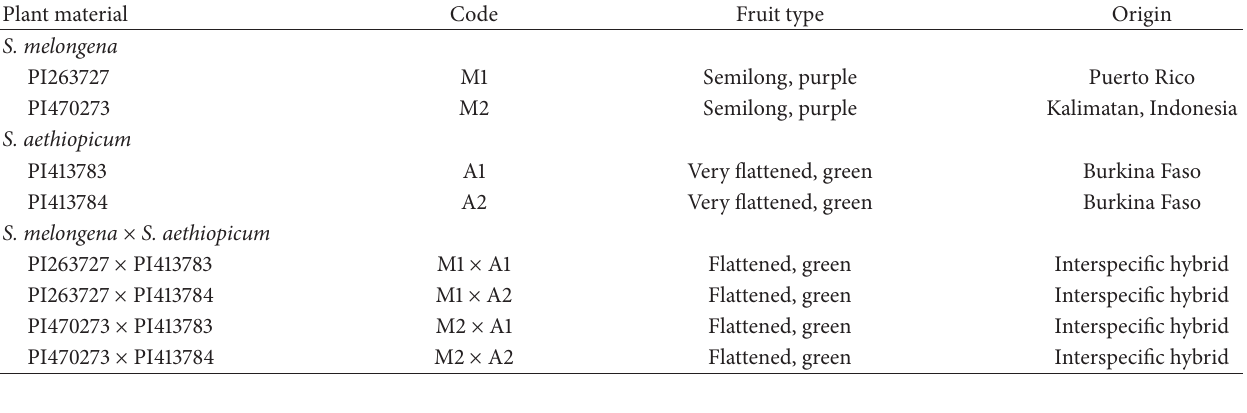
Table 1: Plant materials used, codes, fruit characteristics, and their origins.